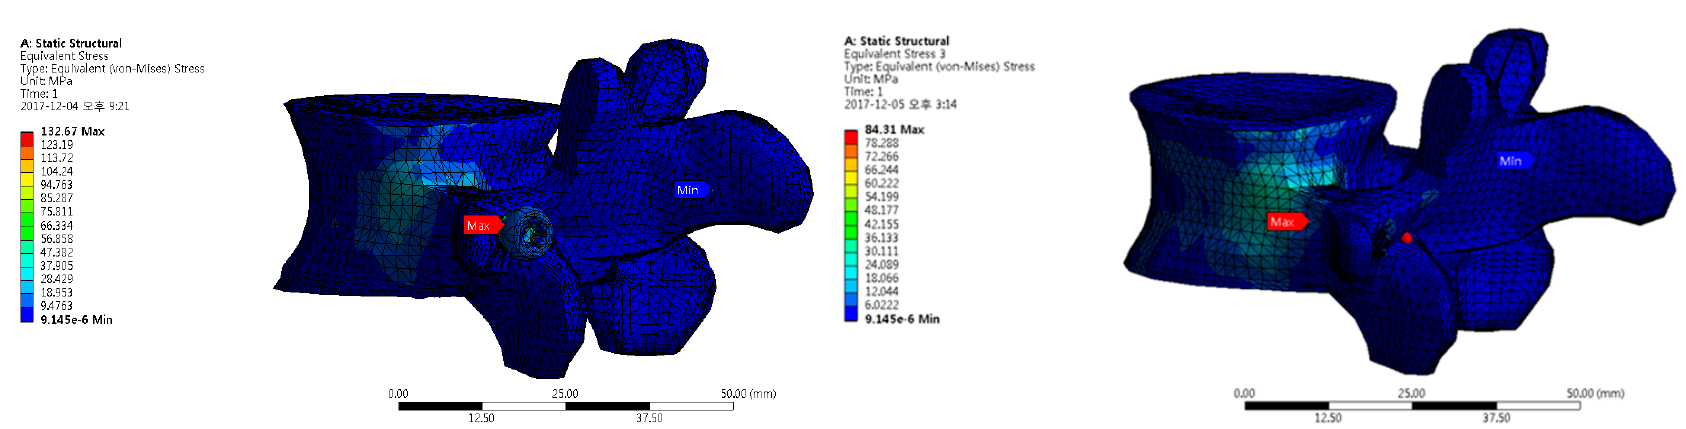
Figure 10. FEA results for the proposed pedicle screw: Top is the pedicle screw, left is L4 and the pedicle screw, and right is